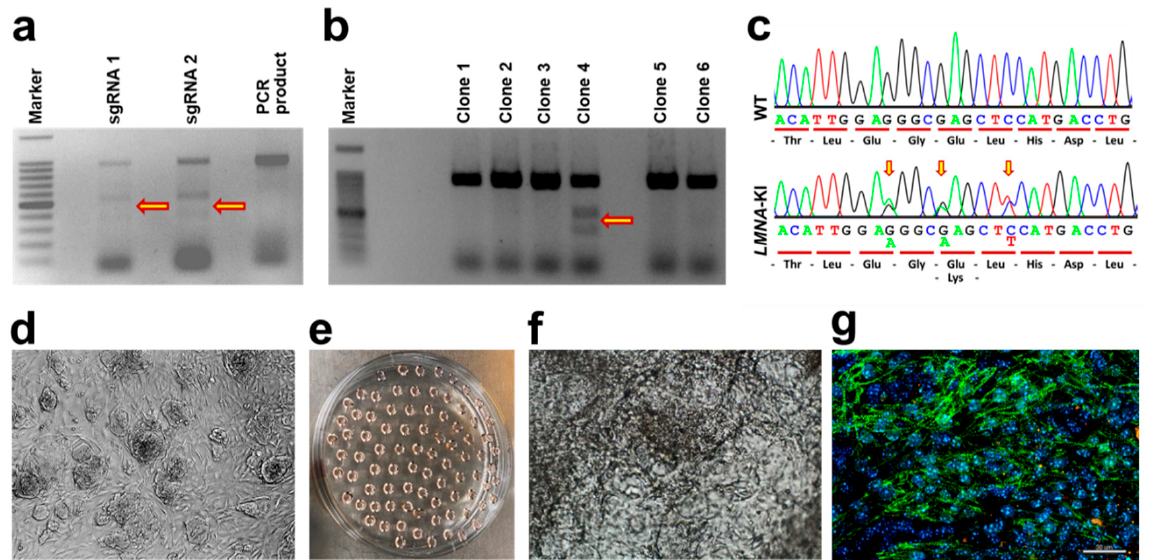
Figure 2. CRISPR-Cas9 mediated patient-specific knock in mES cell line generation and differentiation into cardiomyocytes. ( a ) Surveyor nuclease assay to validate two different sgRNAs (1 and 2) for use in mES cells. Arrows indicate the successful cleavage of PCR products by sgRNAs. ( b ) Hind III restriction digest of PCR product of the target region to identify the insertion of donor DNA and presence of a specific mutation in single mES cell clones. Arrow indicates successful cleavage of PCR product. ( c ) Confirmation of positive KI clone via Sanger sequencing. Arrows indicate the insertion of the desired mutation in the mES cell genome. ( d ) WT mES cells are grown on MEF feeder cells. ( e ) Hanging drop culture to initiate cardiomyocyte differentiation from mES cells. ( f ) Differentiated cardiomyocyte from WT mES cells as seen on Day 12 in brightfield microscope. ( g ) Actinin (green) and DAPI (blue) staining in WT cardiomyocytes as seen on Day 12. sgRNA = single guide RNA. Scale bar: 10 µ